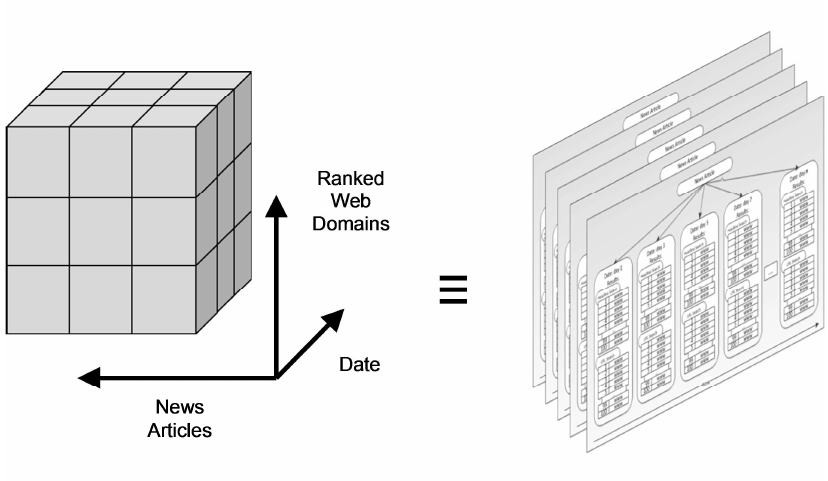
Figure 3: Example OLAP